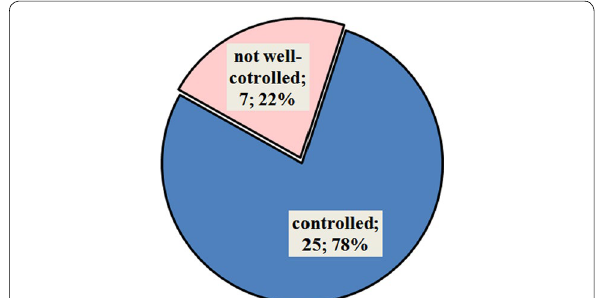
Fig. 1 Allergic rhinitis control: patients’ distribution